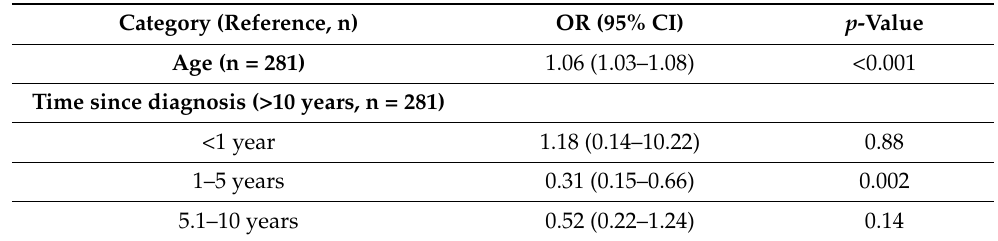
Table 2. Logistic regression predicting vaccine uptake using socio-demographic and clinical